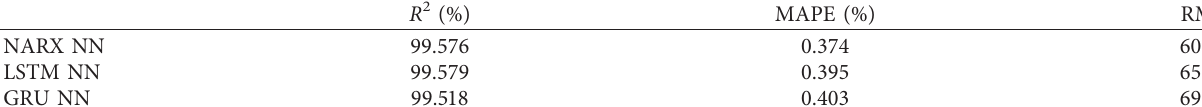
Table 6: Accuracy evaluation of traffic flow forecasting with three